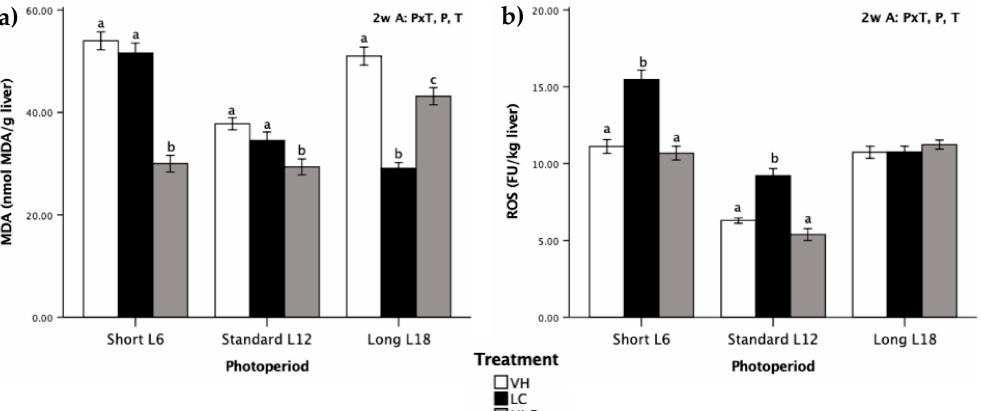
Figure 3. Liver oxidative stress biomarkers in Fischer 344 rats exposed to three different photoperiods for 7 weeks and supplemented with local sweet cherry (LC), non-local sweet cherry (NLC), or vehicle (VH): ( a ) malondialdehyde (MDA) level; ( b ) reactive oxygen species (ROS) generation. Data are expressed as the mean ± SEM ( n = 8). Two-way ANOVA [3 × 3 factorial designs: treatment (LC, NLC, or VH) × photoperiod effect (L6, L12, or L18)] was used to evaluate the differences between the groups, thus we could determine the effects of the photoperiod, P; the treatment, T; or the photoperiod × treatment interaction, P × T. Later on, one-way ANOVA was used to evaluate significant differences among the treatments (LC, NLC, and VH) within each photoperiod exposure (Short L6, Standard L12, and Long 18); these differences are indicated with different letters. Abbreviations: L6: 6 h light / day, L12: 12 h light / day, L18: 18 h light / day, SEM: standard error of the mean, ANOVA: analysis of variance.